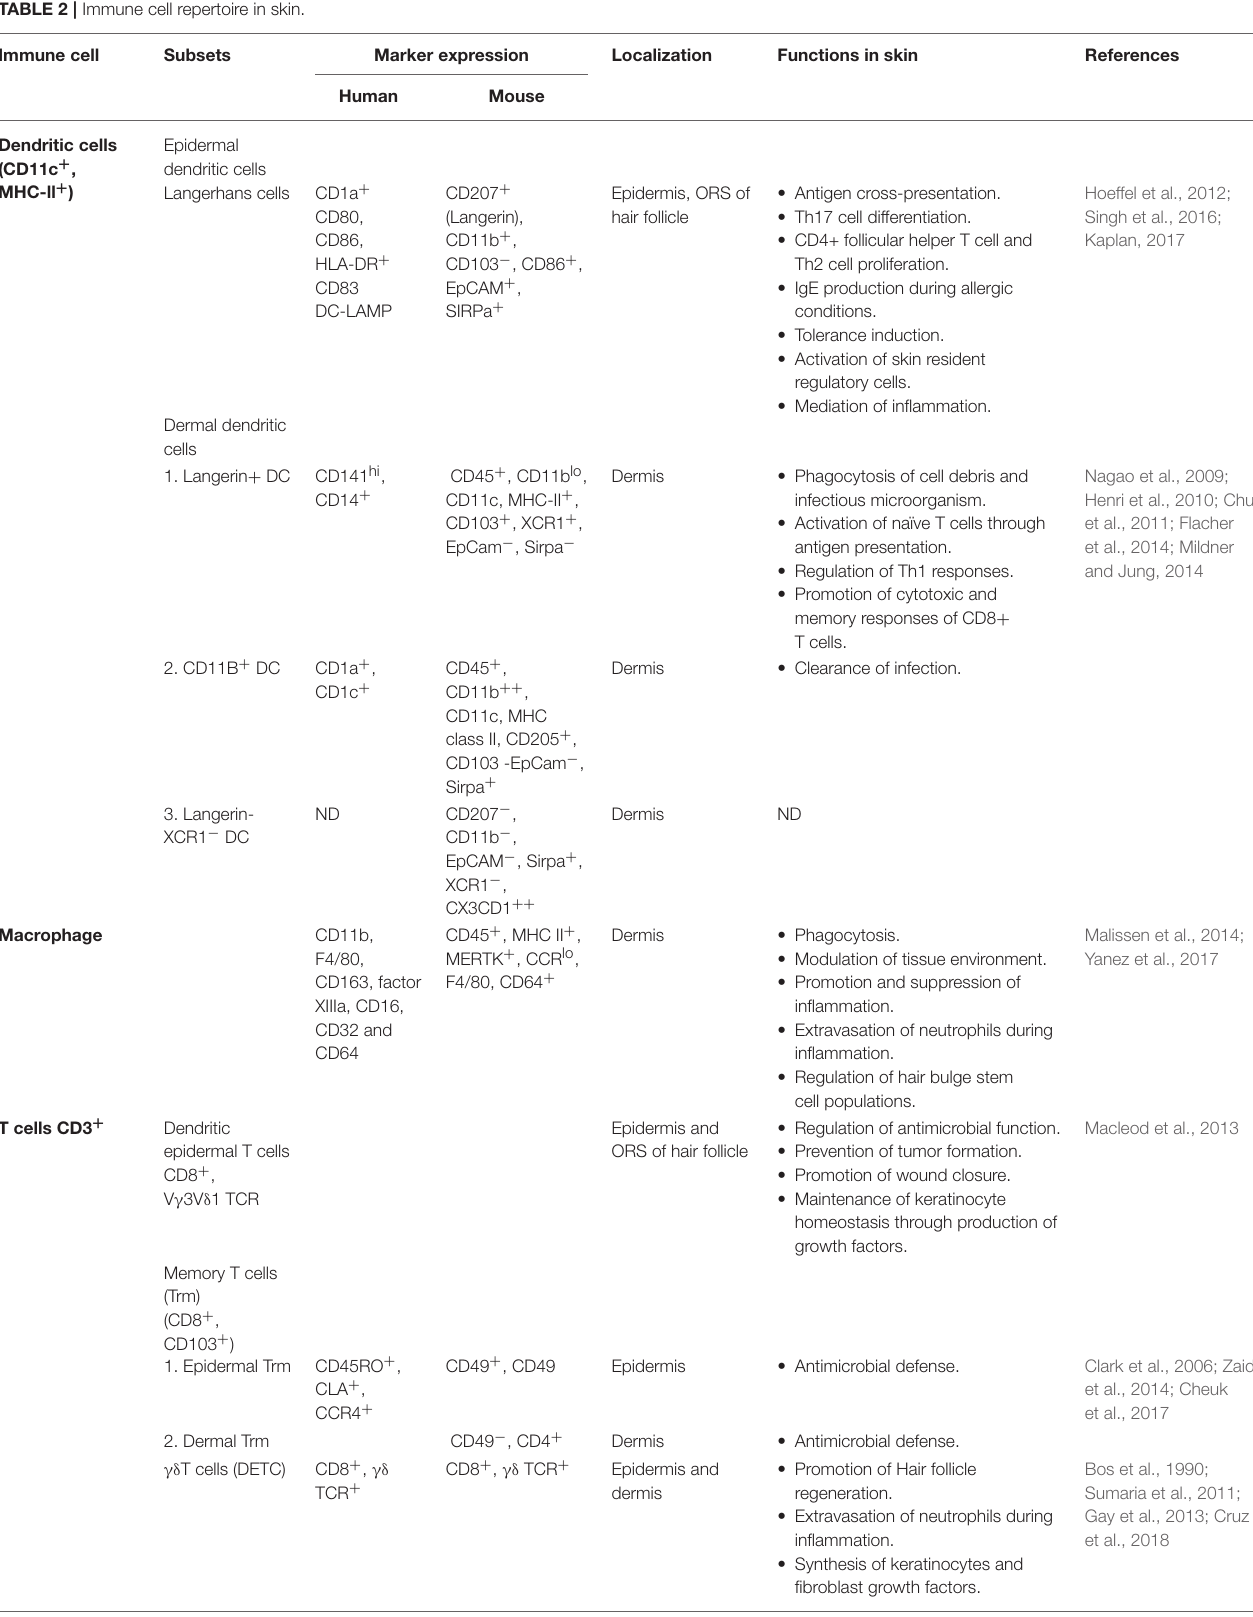
TABLE 2 | Immune cell repertoire in skin. Immune cell Subsets Marker expression Localization Functions in